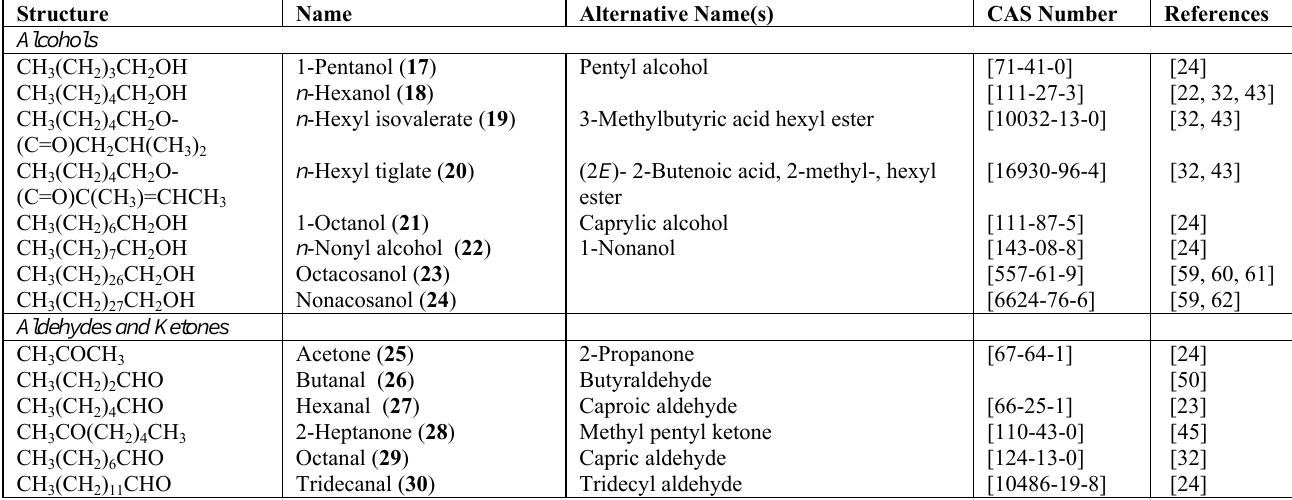
Table 2. Saturated Unbranched Alcohols, Aldehydes and